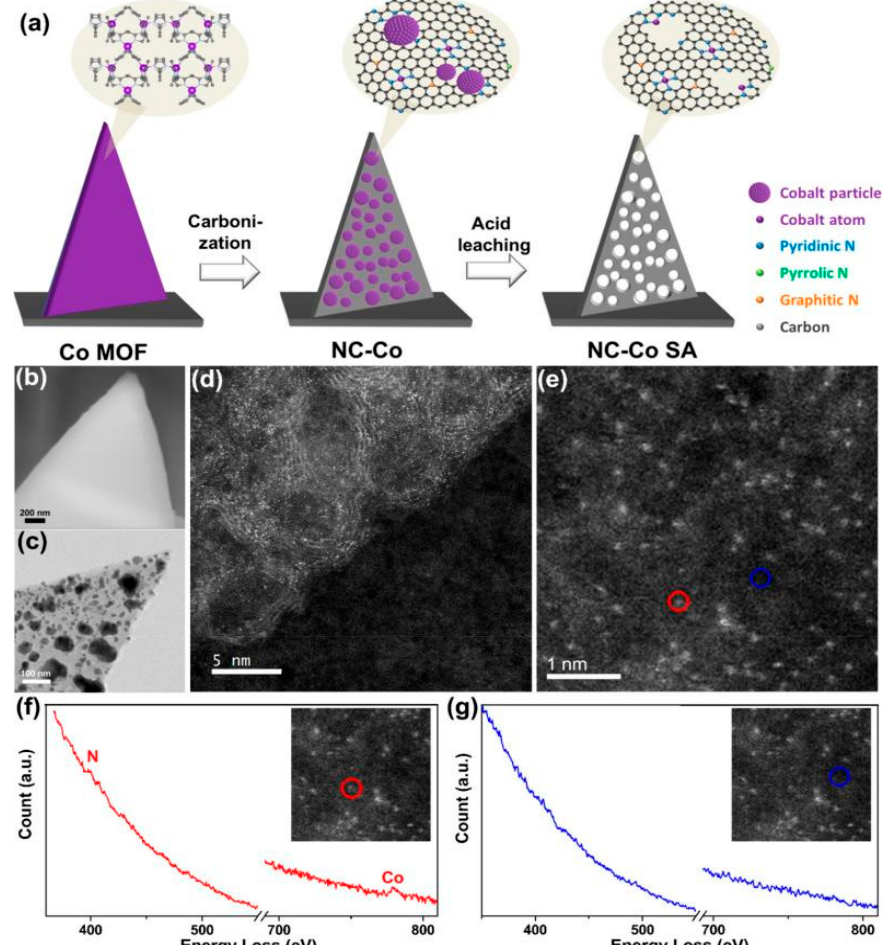
Figure 5. ( a ) Schematic diagram of the NC-Co SA fabrication process; ( b ) SEM image of Co MOF. ( c ) STEM image of NC-Co; ( d ) STEM image of NC-Co SA; ( e ) HAADF STEM image of Co atoms distributed across the nitrogen-doped carbonaceous support; ( f ) EEL spectra taken at the bright atom in the red circle in ( e ) showing Co and N edges; ( g ) EEL spectra taken at the dark support area in the blue circle in ( e ) showing neither. Copyright 2018, American Chemical Society